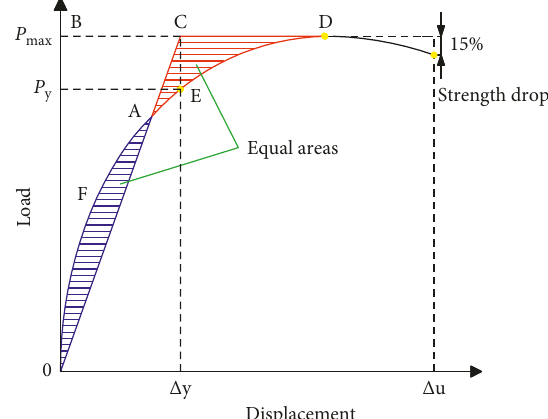
Figure 11: Method used to define the yield and ultimate displacement.